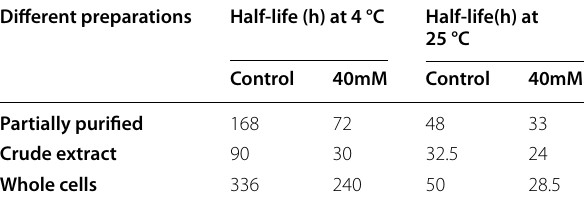
Table 5 The calculated half-lives of different preparations of